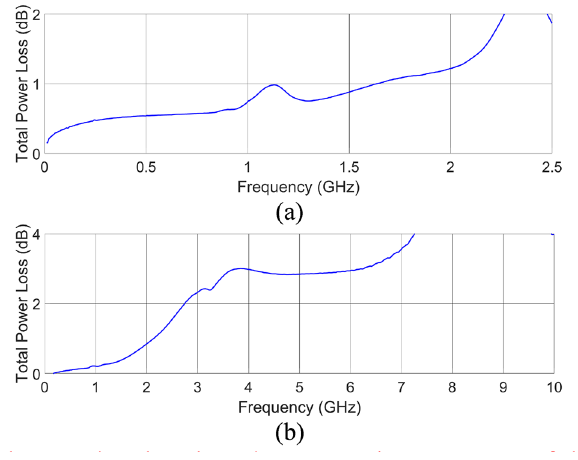
Figure 7. Calculated total power loss based on the measured S-parameters of the fabricated unit of a directional coupler ( a ) and a low-pass filter ( b